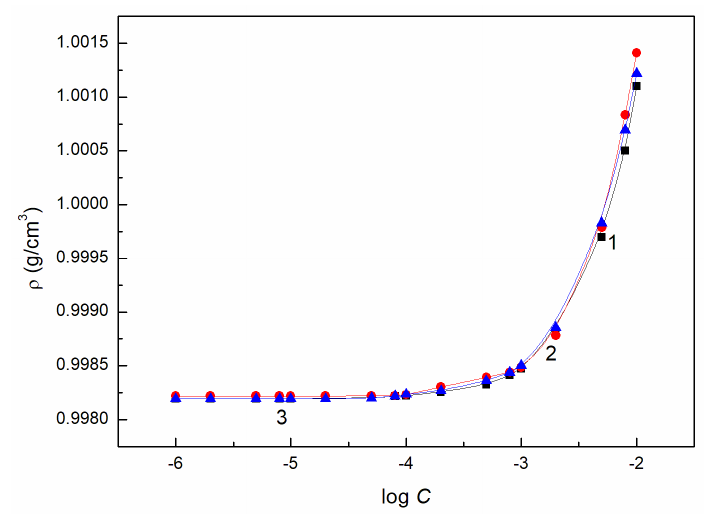
Figure 6. A plot of the density ( ρ ) of the aqueous solutions of AuO + RH40 (curve 1, squares), AuO + ELP (curve 2, circles) and AuO + ELP + RH40 mixtures (curve 3, triangles) vs. the logarithm of RH40, ELP or ELP + RH40 concentration (log C